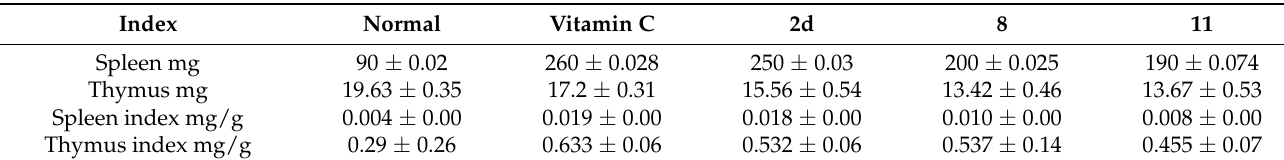
Table 8. Effect of the most promising three derivatives, 2d , 8 , and 11 , on immune organ